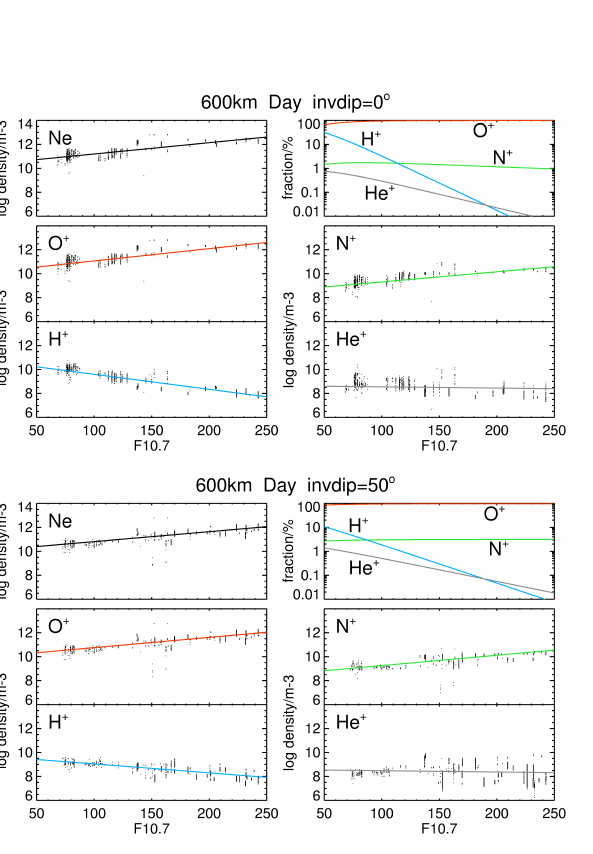
Fig. 3. Dependence of the logarithm of the individual ion densities, of the electron (=total ion) density, and of the relative ion densi- ties on the solar activity level characterized by the actual day val- ues of the F10.7 index. Example for equinox, equator ± 15 ◦ , mid- latitudes 50 ◦ ± 15 ◦ , altitude of 600 ± 80km, and daytime 13 ± 3h MLT. Points-measured values, lines-values calculated from the models (TTS relative ion density and electron density models).